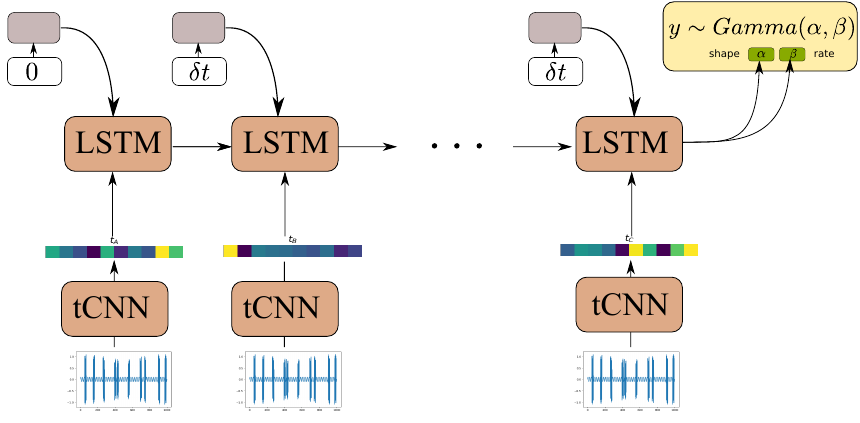
Figure 8. Model architecture of